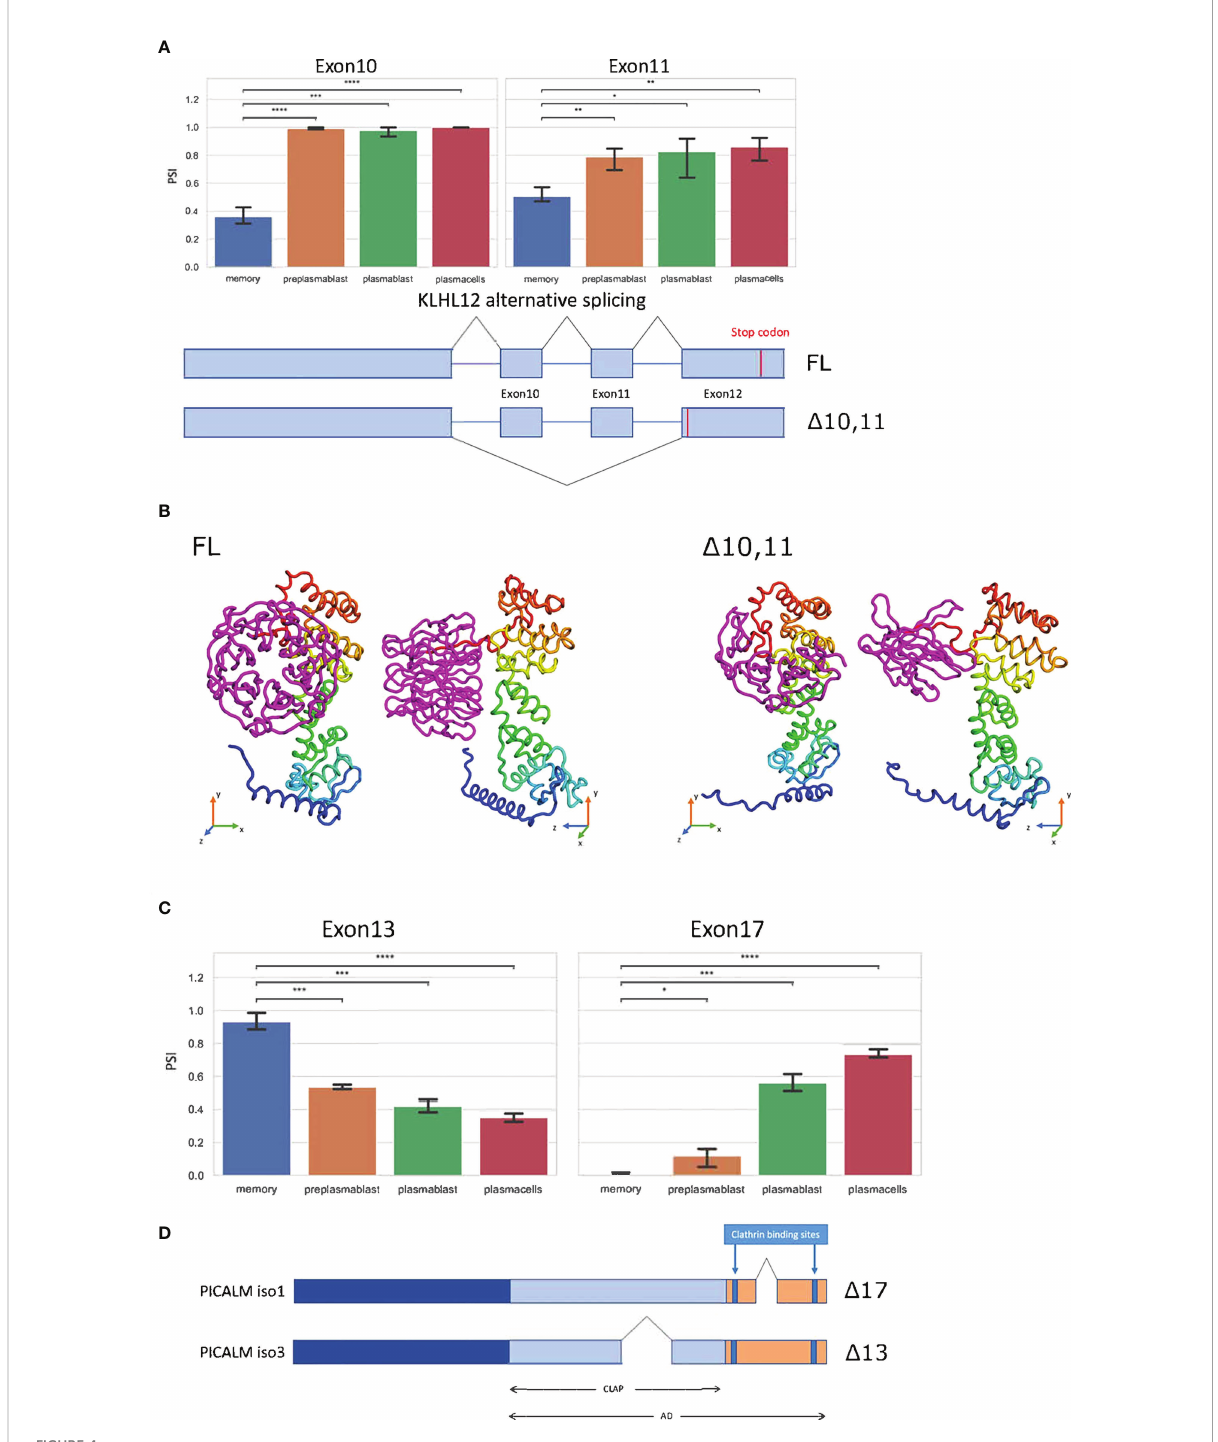
FIGURE 4 Splice events with protein-coding isoforms. (A) Barplot showing PSI of two different splice events in KLHL12 . Schematic summary of KLHL12 alternative splicing and the resulting change of stop codon. (B) Protein structure prediction with Robetta (https://robetta.bakerlab.org/) of the KLHL12 isoforms (FL and D 10,11). The D 10,11 causes a deletion of the kelch domain (colored magenta) (C) Bargraph showing the PSIs of exon 13 and exon 17 of PICALM in differentiation stages of B-Lymphocytes. (D) Schematic summary of PICALM isoforms. Signi fi cance is indicated by asterisks (* P < 0.05, ** P < 0.01, *** P < 0.001, **** P <